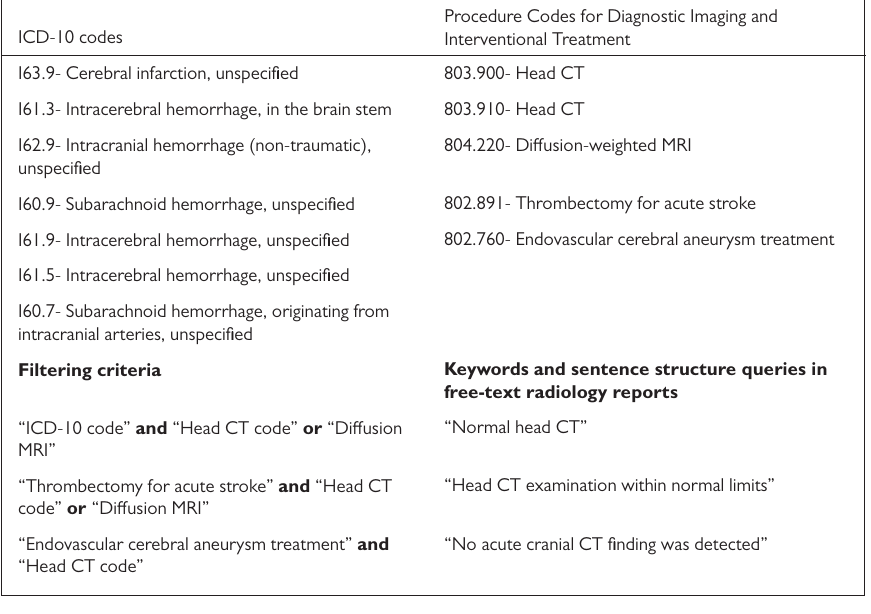
Table 1. The Codes, Filtering Rules, Keywords, and Sentence Structures Used in the Data Search Are Shown ICD-10